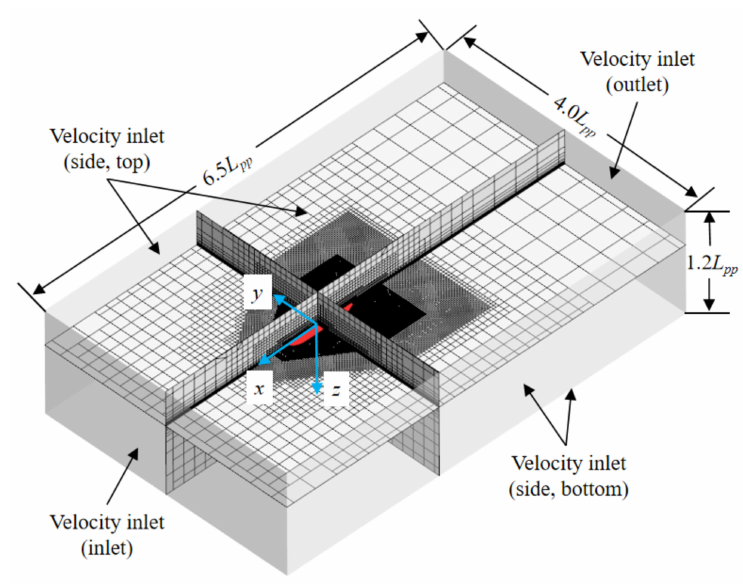
Figure 3. Computational domain and boundary conditions.